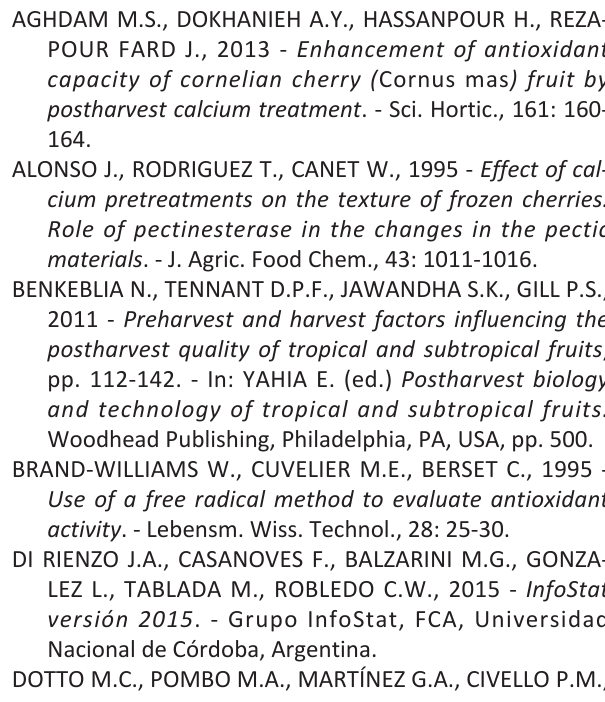
Different capital letters indicate differences between row and different small letters indicate differences between columns